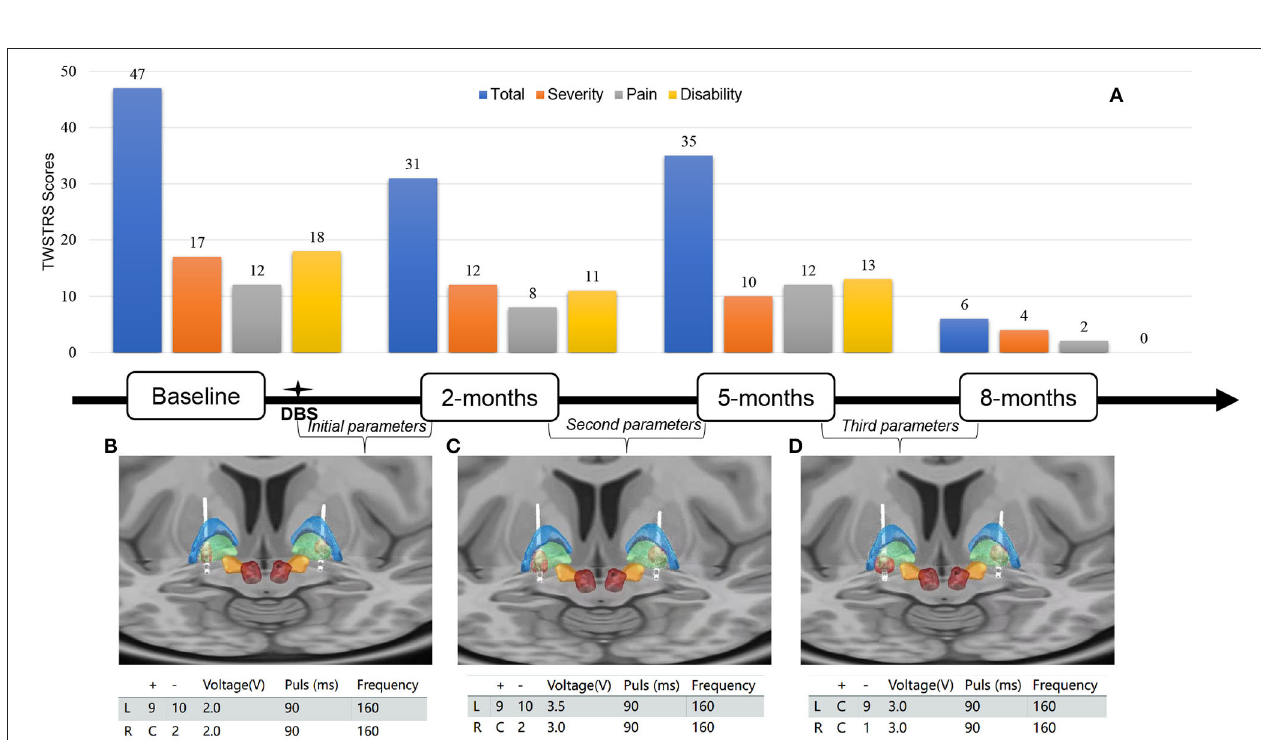
FIGURE 2 | (A) Toronto Western Spasmodic Torticollis Rating Scale (TWSTRS) total, severity, disability, and pain scores at baseline, 2, 5, and 8 months after bilateral GPi-DBS surgery. (B–D) Lead location of bilateral globus pallidus internus-deep brain simulation (GPi-DBS) and volume of tissue activated (red) in the initial, second, third programming parameters. Globus pallidus internus (green), globus pallidus externus (blue), subthalamic nucleus (orange), and red nucleus (deep red). For localizing the anatomical electrode position and determining the volume of tissue activated (VTA), T1-weighted magnetization prepared rapid gradient echo (MP-RAGE) images of the patient were obtained preoperatively and registered with post-operative high-resolution CT using the Lead-DBS software package.